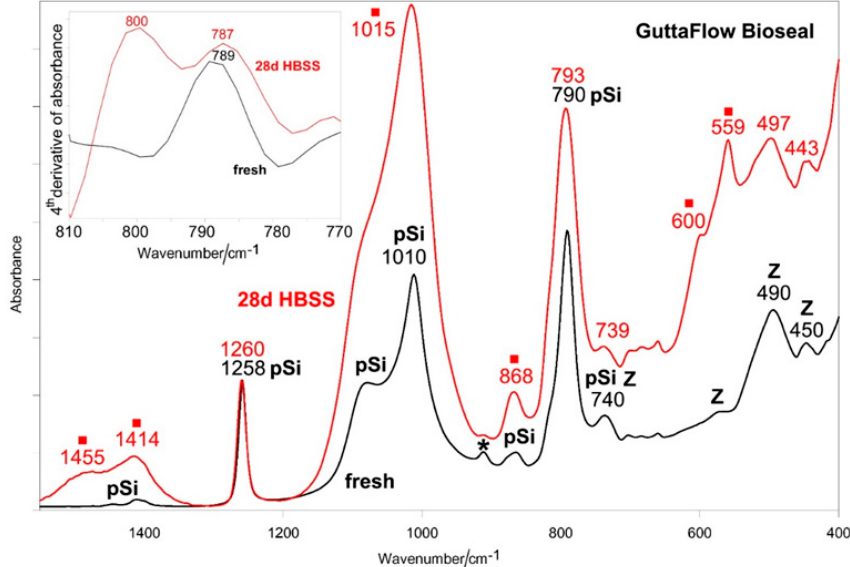
Figure 7. Average IR spectra recorded on the surface of GuttaFlow Bioseal before (i.e., fresh) and after aging in HBSS for 28 days. The spectra are normalized to the absorbance of the 1258 cm − 1 band. The bands assignable to polydimethylsiloxane (pSi) and monoclinic zirconia (Z) are indicated together with those specifically assigned to unreacted Si-H bonds (*) and B-type carbonated apatite ( ■ ). The inset shows the fourth derivative IR spectra in the 810–770 cm − 1 range. More detailed assignments are reported in the text and summarized in Table S1, Supplementary Material.